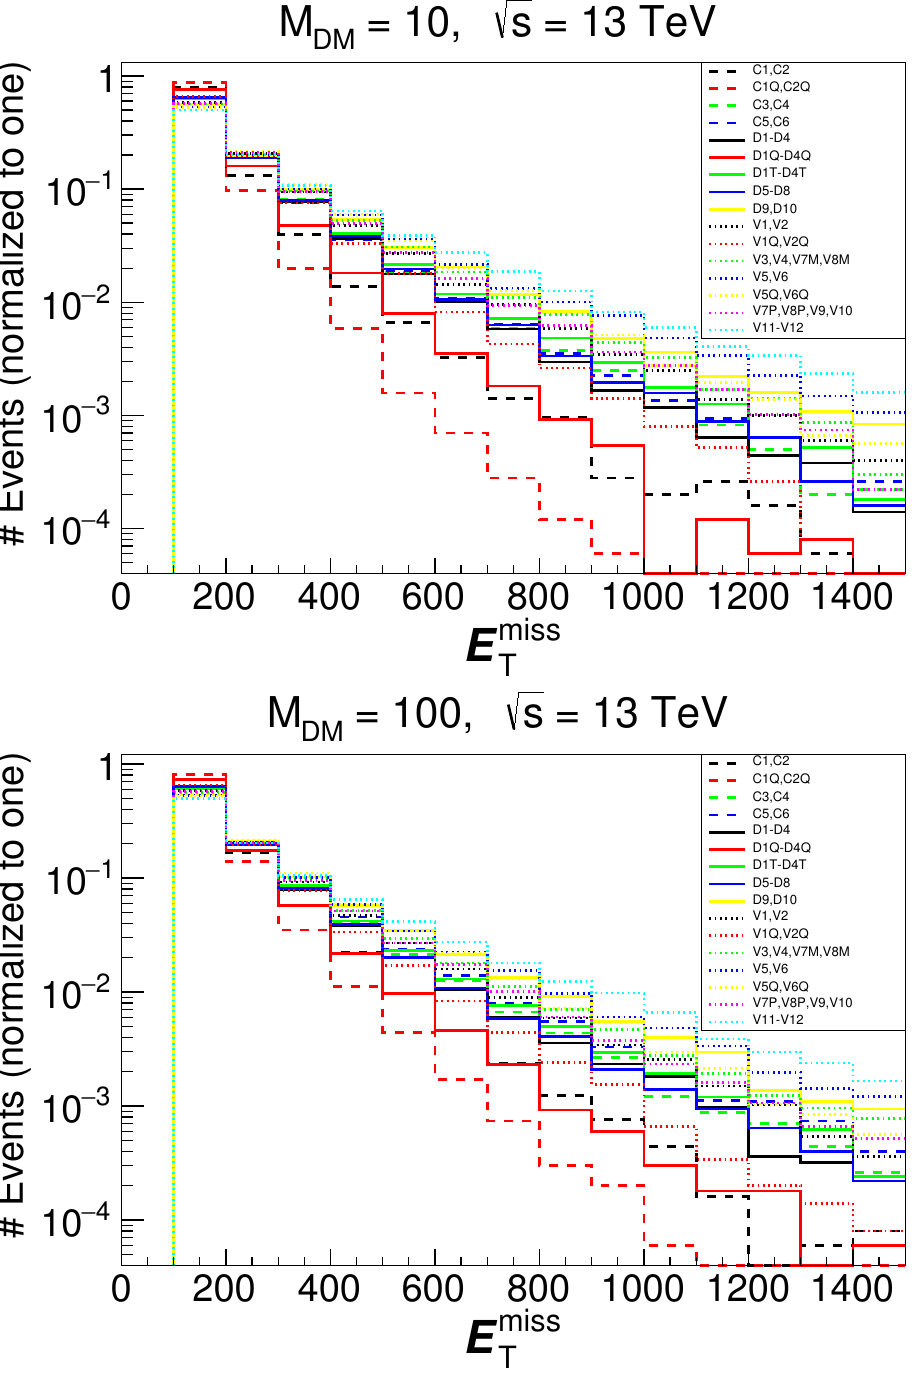
Figure 2 . E miss parton level distributions for a representative subset of the EFT operators listed T in tables 1 and 2 for 13 TeV LHC energy. The panels di(cid:11)er by the mass of the DM candidate: M DM = 10 GeV (top), 100 GeV (bottom). A p T; jet (cid:21) 100 GeV cut has been applied in both plots.